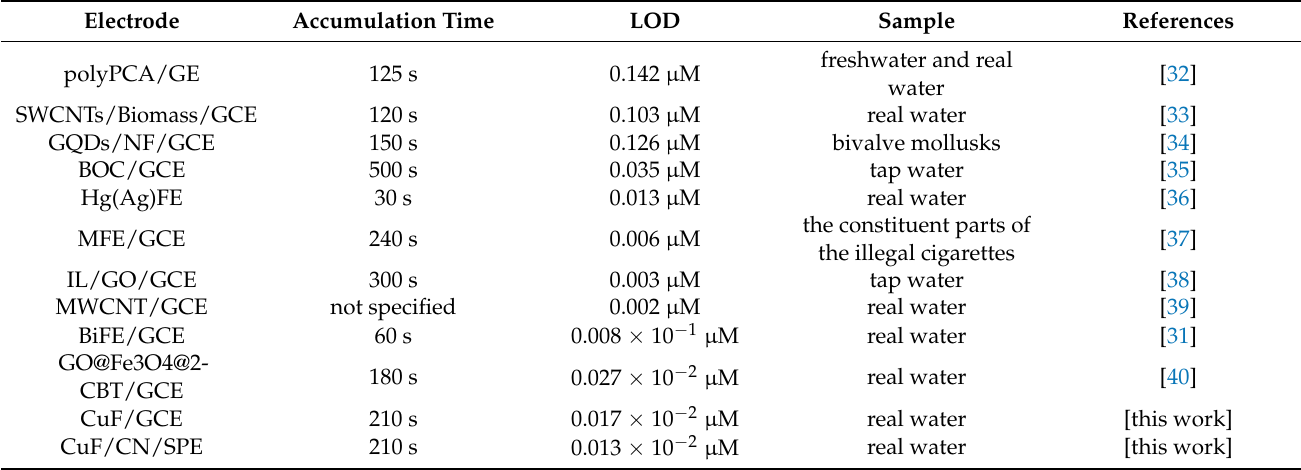
polyPCA/GE—graphite electrodes modified with poly( p -coumaric acid), SWCNTs/Biomass/GCE—glassy carbon electrode modified by a mixture of single walled carbon nanotubes and biomass, GQDs/NF/GCE—glassy carbon electrode modified with graphene quantum dots and Nafion, BOC/GCE—glassy carbon electrode modified bismuth oxycarbide, Hg(Ag)FE—renewable mercury film silver-based electrode, MFE/GCE—glassy carbon electrode modified mercury film, IL/GO/GCE—glassy carbon electrode modified graphene oxide and ionic liquid, MWCNT/GCE—glassy carbon electrode multi-walled carbon nanotube electrode, BiFE/GCE—glassy carbon electrode modified bismuth film, and GO@Fe3O4@2-CBT/GCE—glassy carbon electrode modified with magnetic graphene oxide modified with